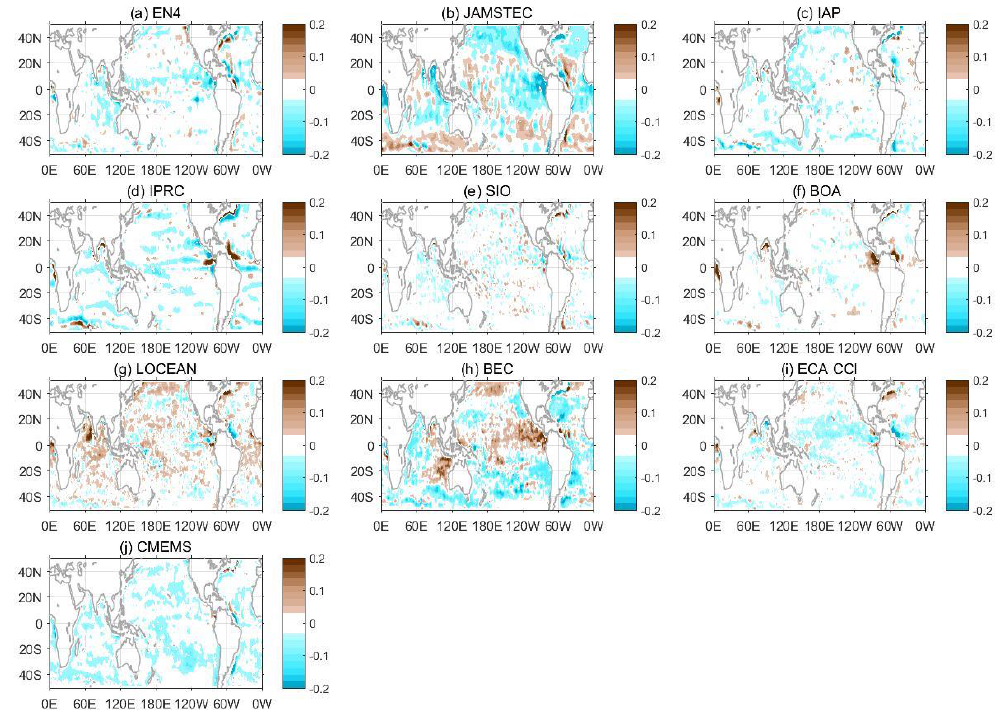
Figure 2. The difference in the climatological mean SSS between each gridded product and the ensemble mean fields. The units for salinity anomalies are g/kg.